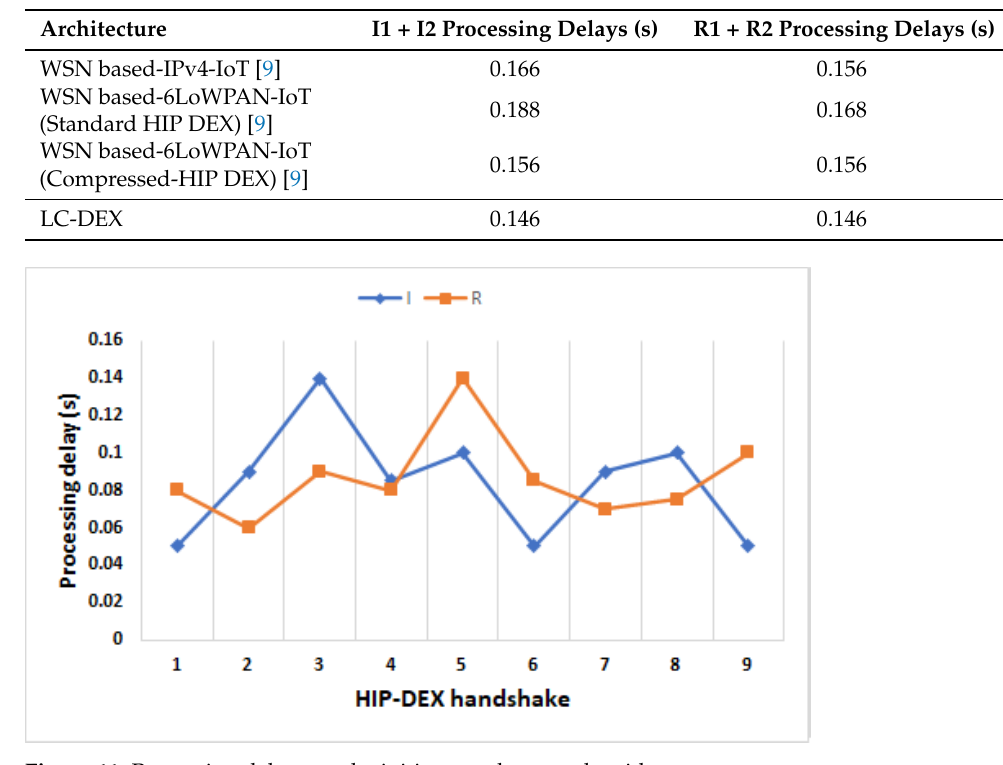
Figure 11. Processing delays on the initiator and responder sides. Table 10. Processing delays’ (s) comparison with previous